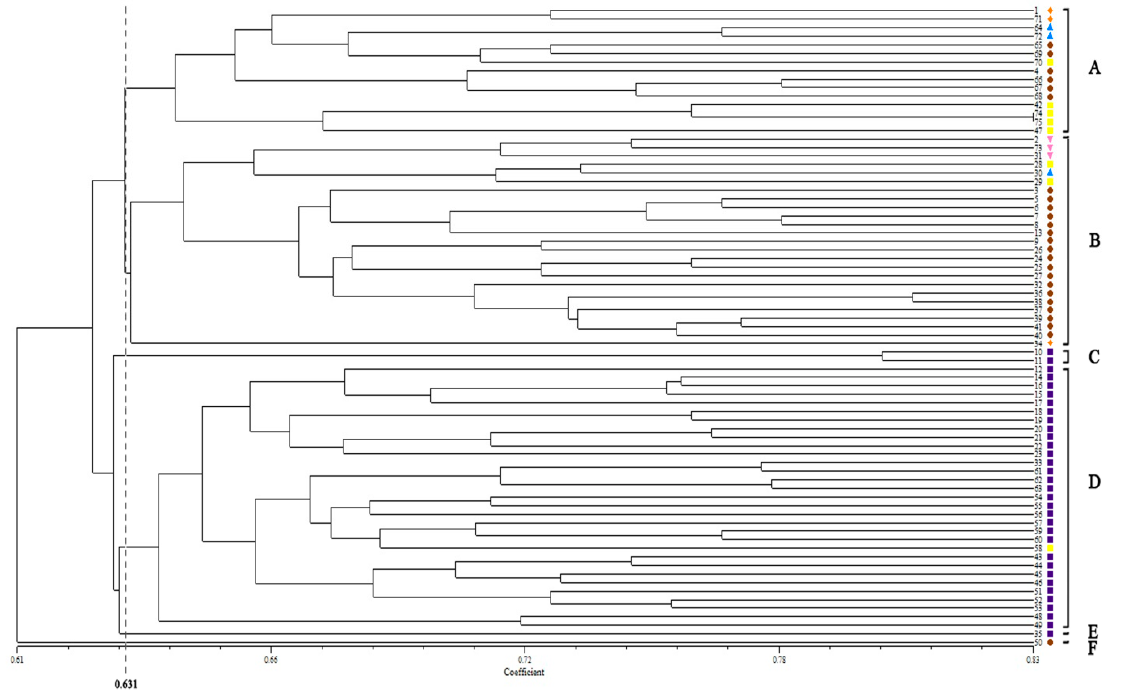
Figure 1. The UPGMA dendrogram of 75 orchardgrass accessions. The symbols represent the geographic groups in cluster tree as ◆ (orange) accessions from North America, ● (brown) accessions from Asia, ■ (purple) accessions from Europe, ■ (yellow) accessions from Africa, ▲ (blue) accessions from South America, and ▼ (pink) accessions from Oceania. A–F represent the 75 orchardgrass samples could be clearly divided into six groups by the UPGMA dendrogram when the genetic coefficient was approximately 0.631.